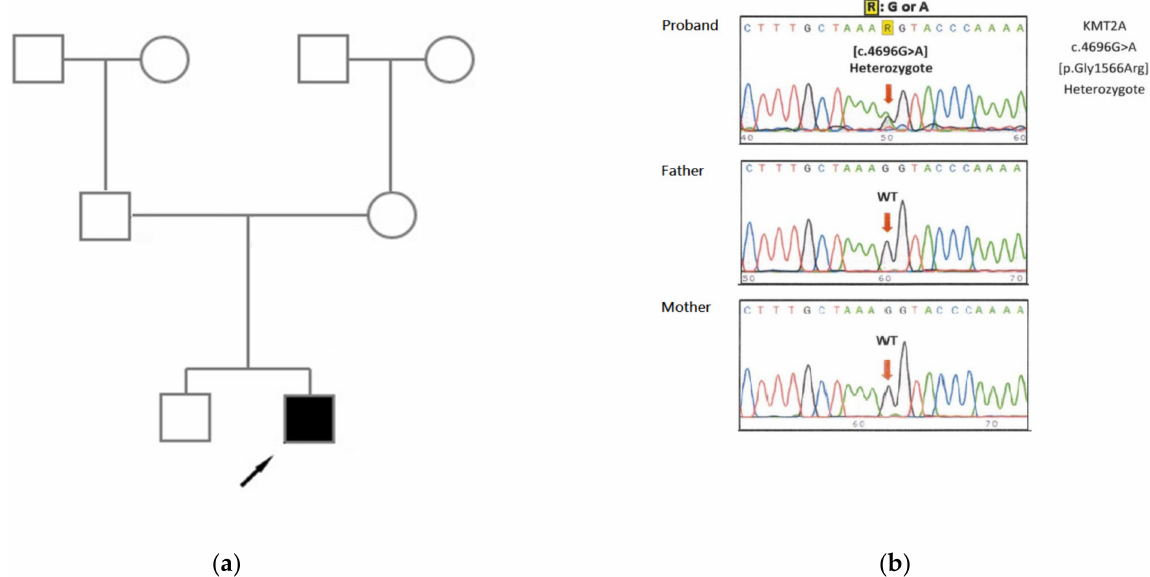
Figure 2. NM_001197104.2: c.4696G>A (p.Gly1566Arg) variation by Sanger sequencing. ( a ) Patient family tree. The blank squares and circle indicate unaffected males and females, respectively; the filled square indicates an affected male, and the arrow indicates the proband. ( b ) Electrophogram of heterozygous KMT2A c.4696G>A (red arrow). Both parents carried the wild-type sequence at this